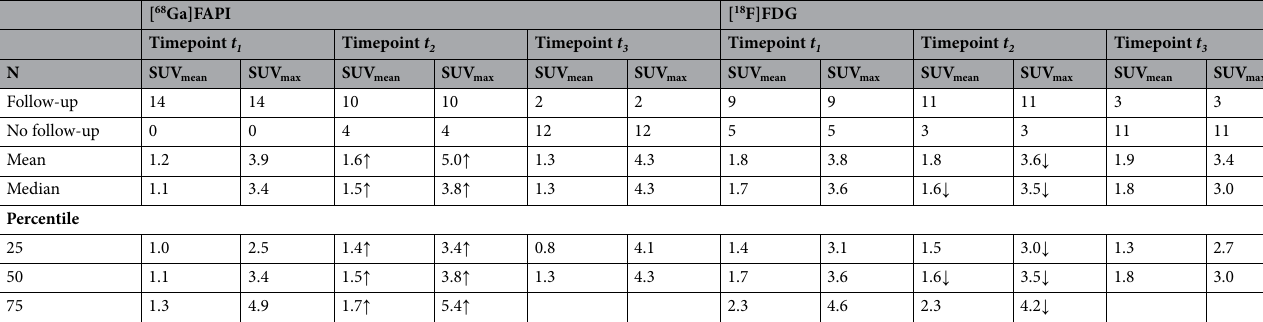
Table 2. Displaying mean and median change of SUV mean and SUV max of perilesional background on [ 68 Ga] FAPI- on [ 18 F]FDG-PET/CT-images at timepoints t 1 , t 2 and t 3 for patient A–N (prior and after radiation therapy treatment completion), with patients A, C and I receiving no radiation therapy. Patient A, C, L and N did not receive a second follow-up [ 68 Ga]FAPI-PET/CT (n = 4), while patient B and G underwent a third [ 68 Ga] FAPI-PET/CT (n = 2). Blue arrows indicating direction of uptake change on follow-up imaging at timepoint t 2 in comparison to timepoint t 1